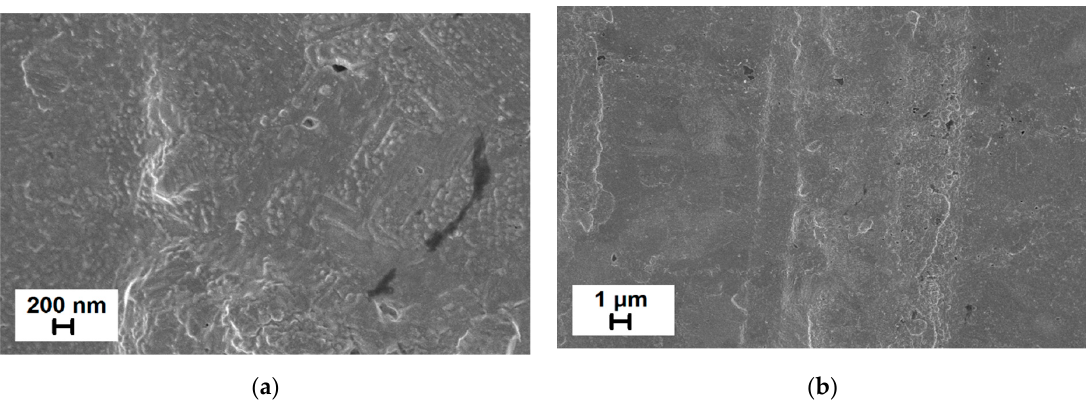
Figure 2. SEM images of waste battery powder before leaching (sample 0), where ( a ) and ( b ) are presented in different scale.